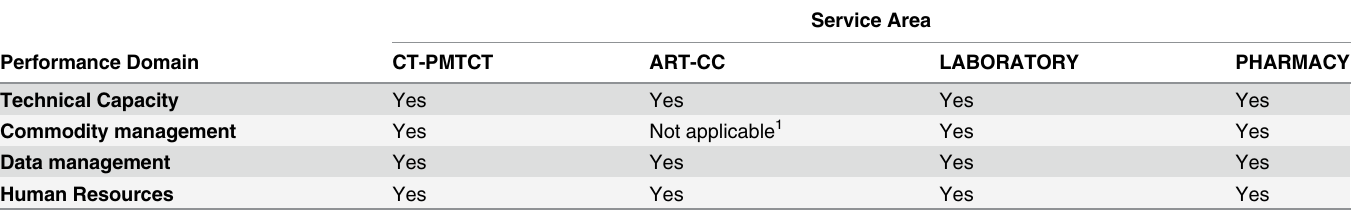
Table 1. Performance Domains by technical service